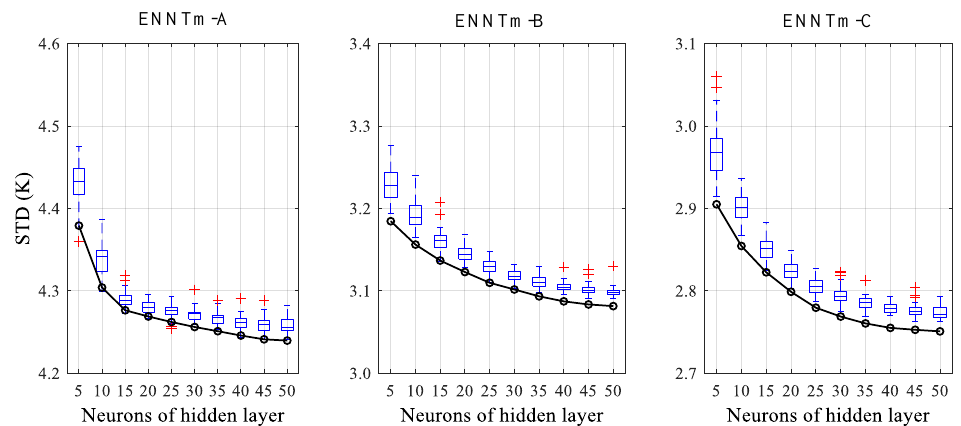
Figure 6. The STD of different modeling schemes with different BPNN structures.